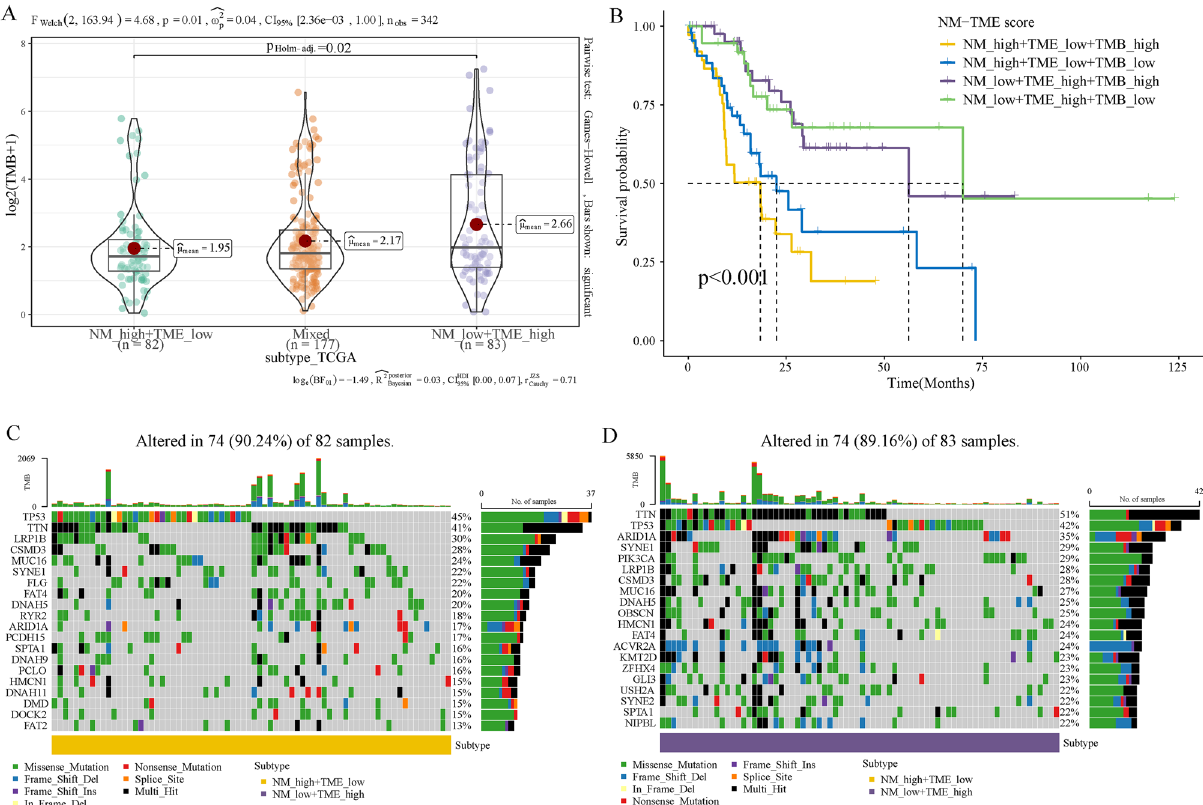
Figure 7. TMB analysis. ( A ) Comparison of TMB among the defined subgroups. ( B ) Survival analysis based on the NM-TME classifier and TMB. The top 20 mutation genes of the ( C ) NMhigh/TMElow and ( D )